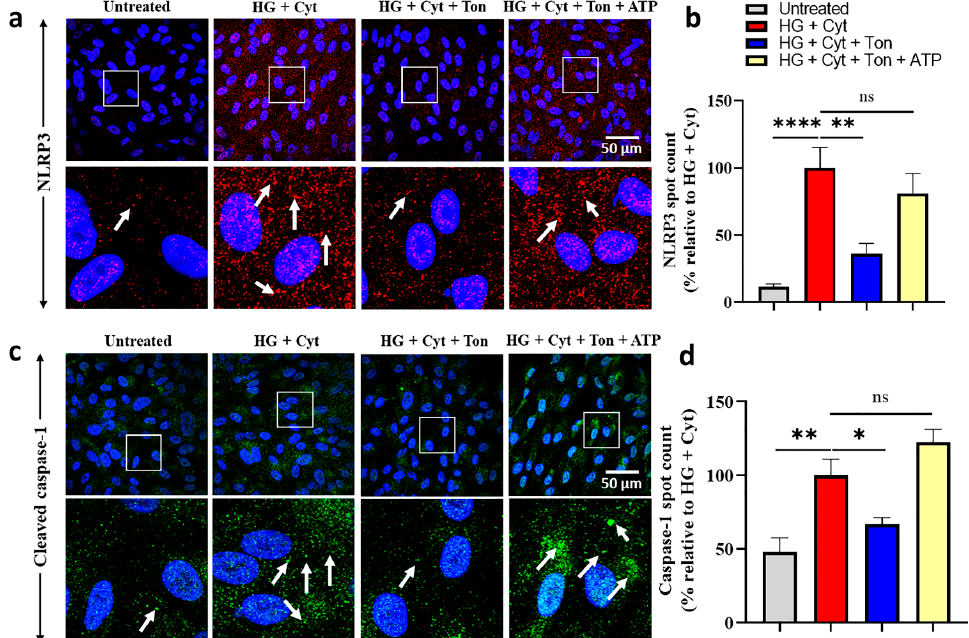
Figure 3. Effect of tonabersat treatment and exogenous ATP addition on HG + Cyt-induced NLRP3 protein and cleaved caspase-1 assembly into inflammasomes. Panel ( a ) shows immunohistochemistry speckle labeling of NLRP3 incorporated into inflammasome complexes, whilst ( b ) shows spot count quantification of that data. Tonabersat treatment (HG + Cyt + Ton) prevented HG + Cyt-induced NLRP3 complex assembly. NLRP3 spot count data showed that HG + Cyt significantly increased NLRP3 spot counts relative to untreated conditions. In comparison, tonabersat treatment significantly prevented an increase in the NLRP3 complex assembly, which remained at baseline levels. The addition of exogenous ATP reversed the protection conferred by tonabersat with no significant difference between the ATP and injury alone groups, indicating that connexin hemichannel-mediated ATP release was the complex assembly-activating signal, with hemichannel block overridden by the addition of exogenous ATP. Panel ( c ) shows immunohistochemical speckle labeling of caspase-1 incorporated into inflammasome complexes, whilst ( d ) shows spot count quantification of that data. Tonabersat treatment also prevented an HG + Cyt-induced increase in cleaved caspase-1 incorporation into inflammasome complexes. HG + Cyt significantly increased cleaved caspase-1 spot counts relative to the untreated group. Tonabersat treatment significantly inhibited HG + Cyt-induced cleaved caspase-1 upregulation, and again, exogenous ATP addition reversed tonabersat effects with no significant difference between the ATP and HG + Cyt groups, indicating that connexin hemichannel-mediated ATP release was the complex assembly-activating signal, with hemichannel block overridden by the addition of exogenous ATP. Boxed areas (50 µm square) are enlarged; arrows illustrate labeled NLRP3 or cleaved caspase-1 spots. Data are presented as mean + SEM. Statistical analysis was carried out using one-way ANOVA with Dunnett’s multiple comparisons test. ns p > 0.05; * p < 0.05; ** p ≤ 0.01; **** p ≤ 0.0001; n = 5; scale bar = 50 µm.